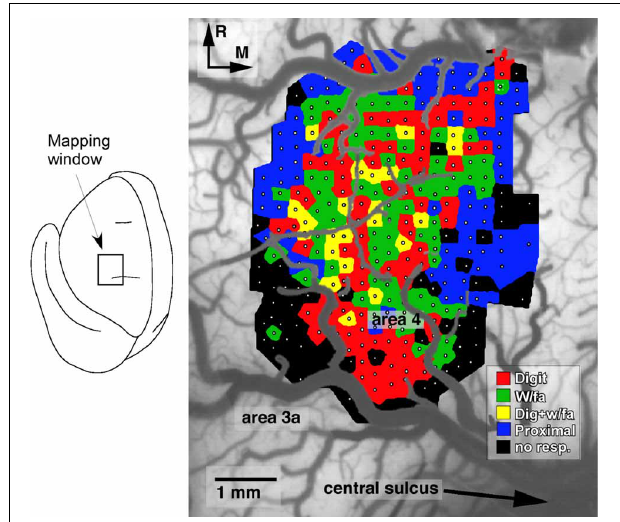
FIGURE 1 | Representation of distal forelimb movements in primary motor cortex (area 4) of a squirrel monkey. Under ketamine sedation, movements were evoked by intracortical microstimulation at each of 321 sites (small white dots) located approximately 250 µ m apart. The distal forelimb representation is comprised of digit (red), wrist (w/fa; green), forearm (green) movements, as well as combinations of single-joint movements (yellow). This fractionated pattern of movement representations is due to the intermingling of corticospinal neurons that project to different subsets of motor neurons (Milliken et al.,